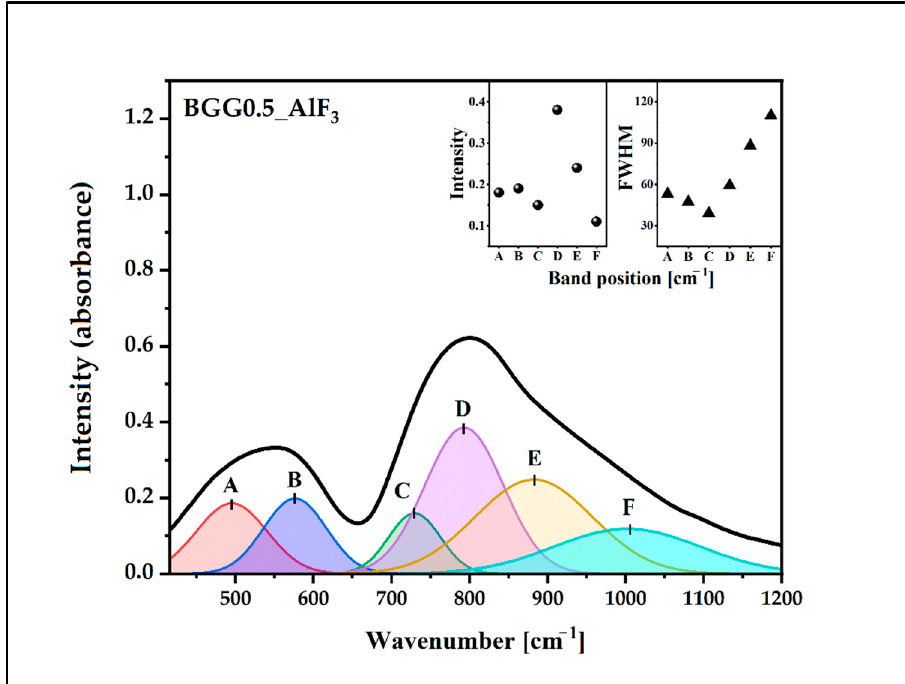
Figure 5. Deconvoluted IR spectrum of BGG0.5Er_AlF 3 glass.